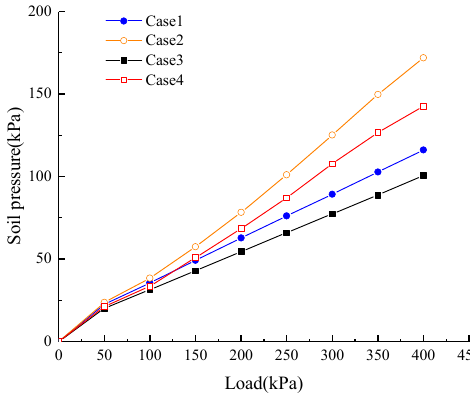
Figure 16. Curve of load–soil pressure.